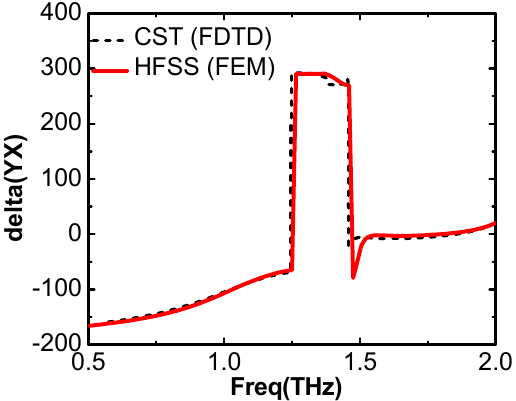
Figure 4. The phase di ff erence between x-polarized and y-polarized transmitted waves with incident x-polarized wave.